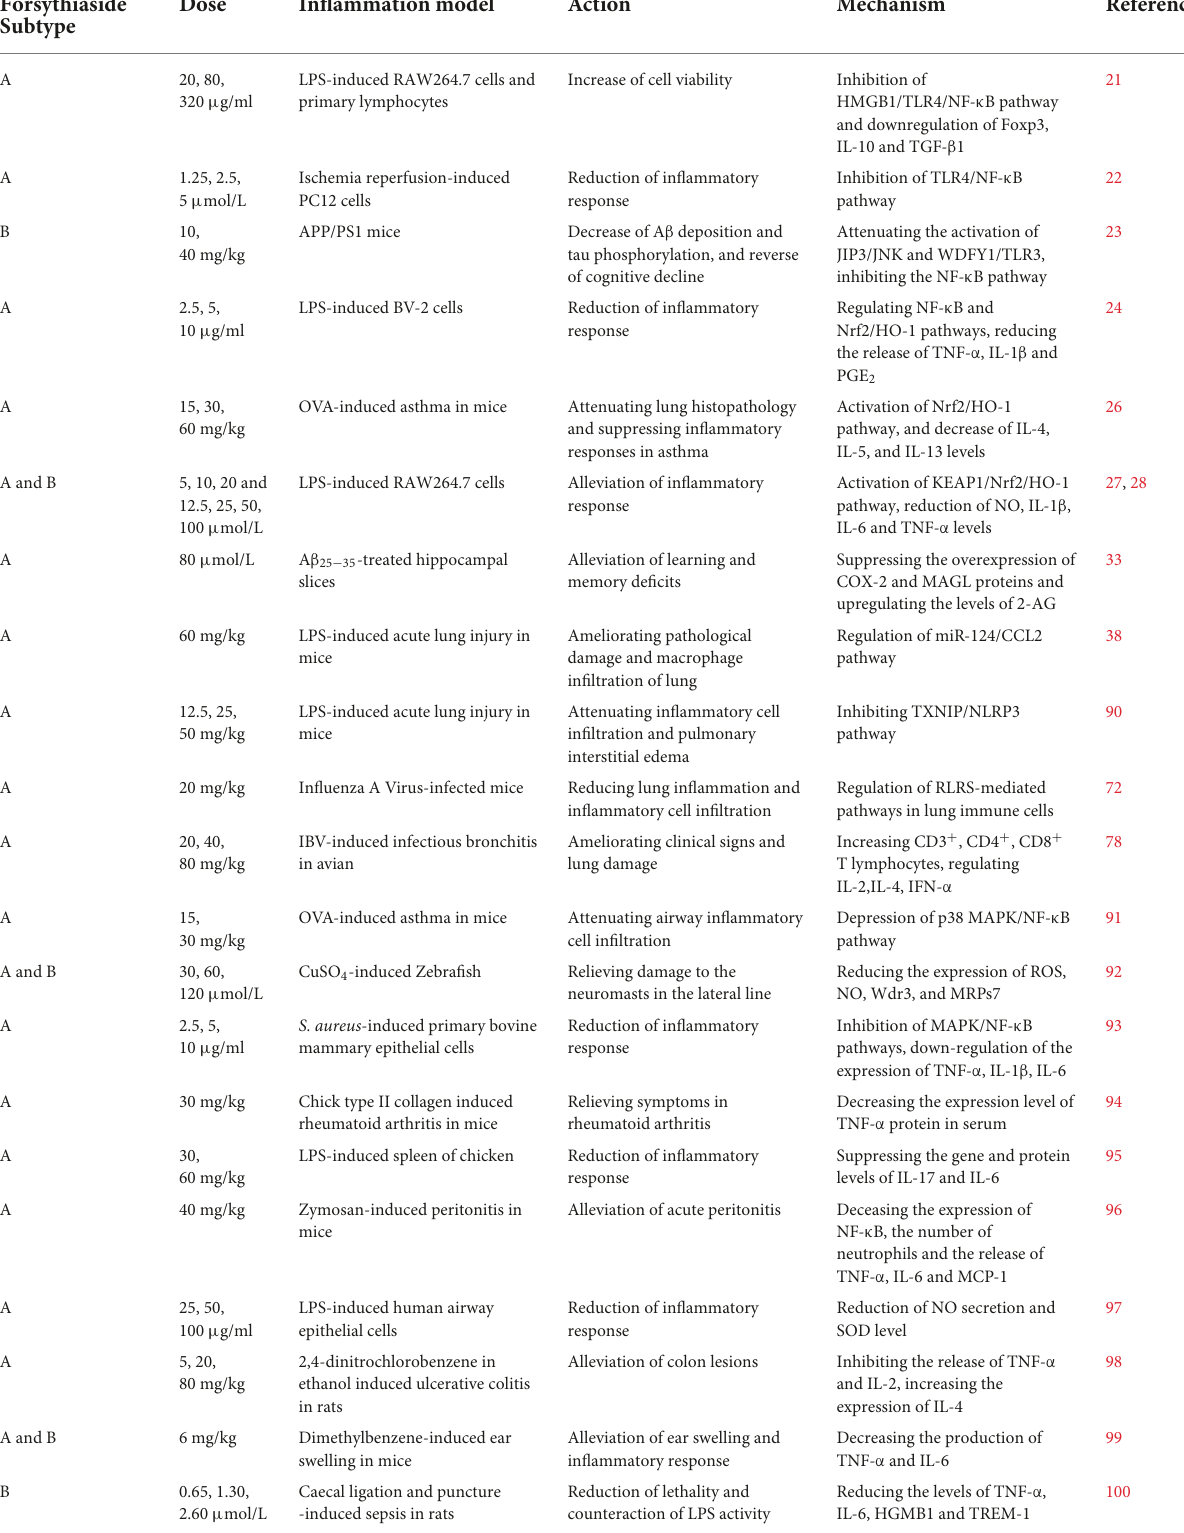
TABLE 2 Anti-inflammatory effects of